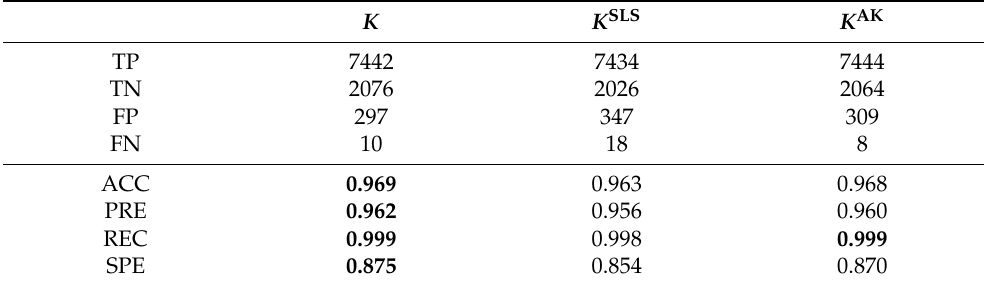
Table 3. Confusion and classification evaluation metrics with different knowledge measures used in the